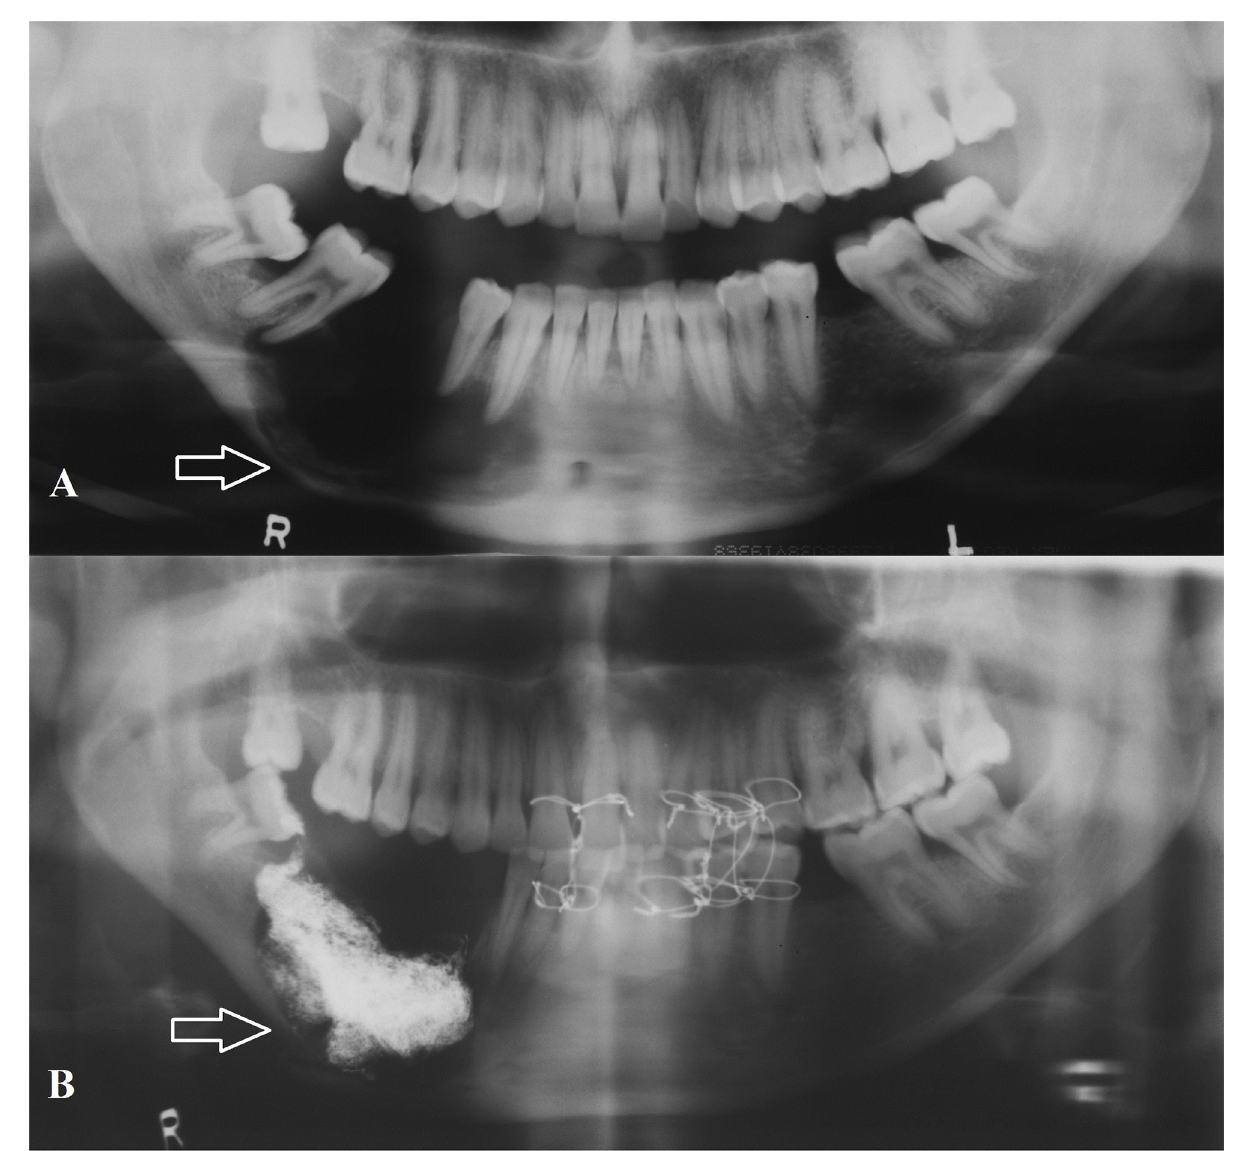
Fig 5. A : Pre-operative panoramic radiograph of residual cyst in the mandible with notable thinning of the mandibular cortex. B : Post-operative panoramic radiograph of same patient showing pathological fracture of mandible with BIPP in situ to prevent post-operative sepsis.